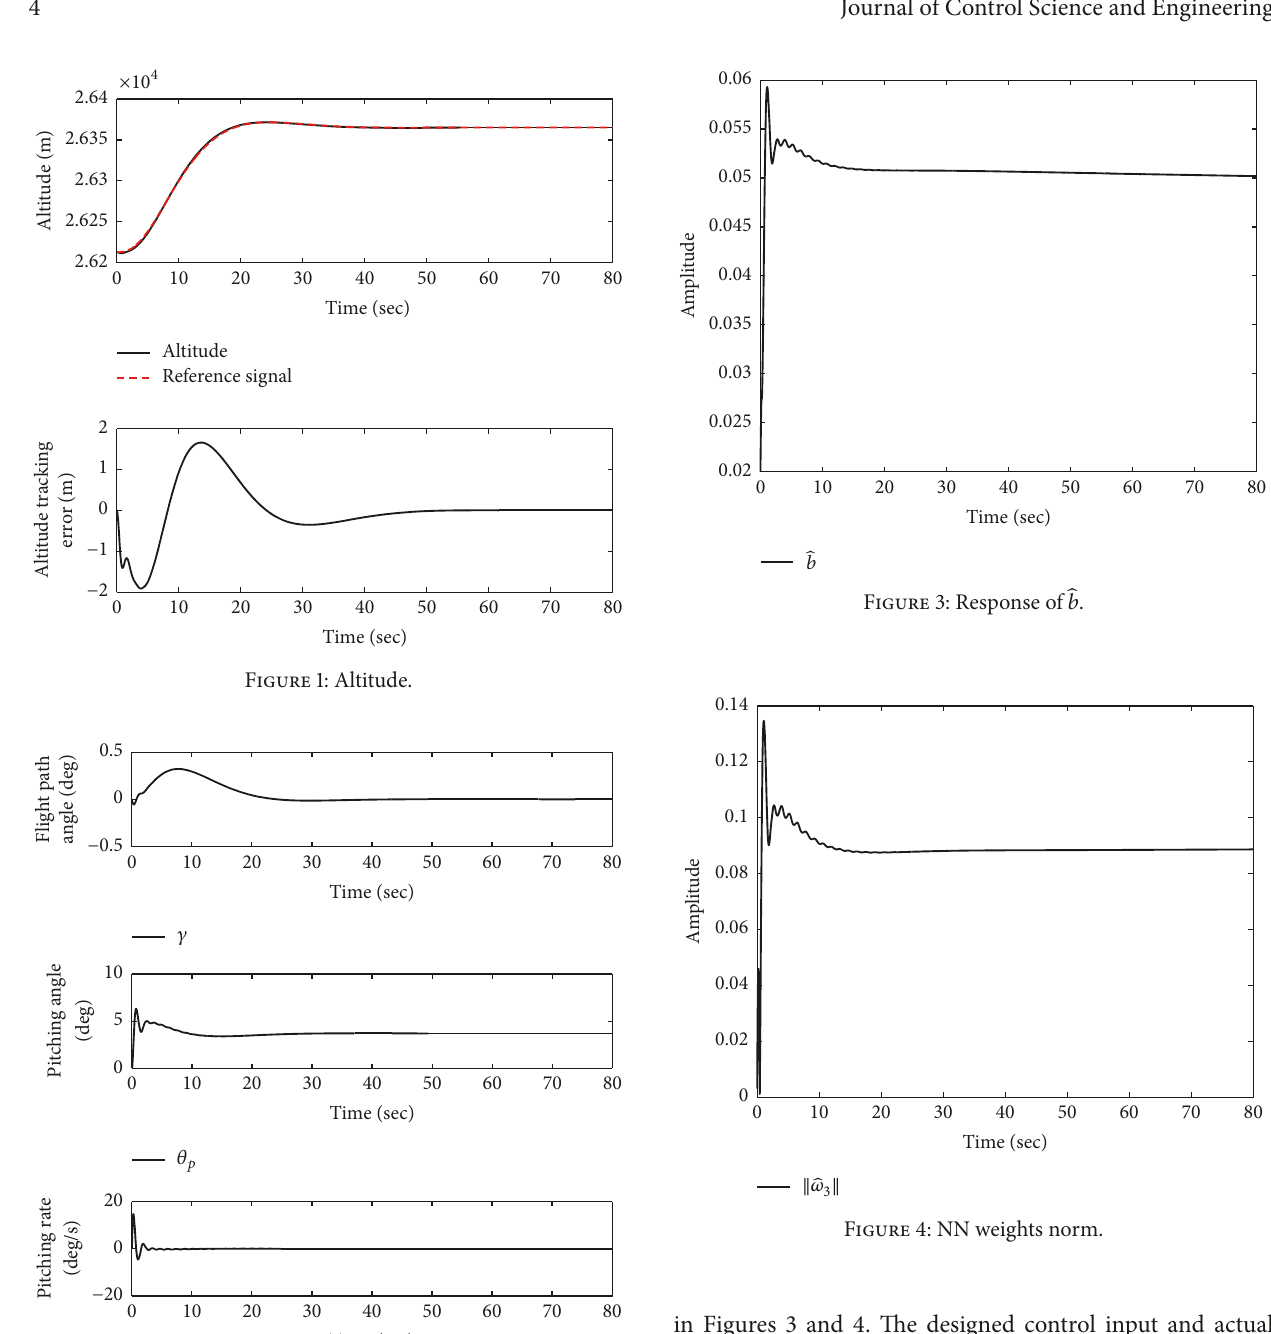
Figure 3: Response of